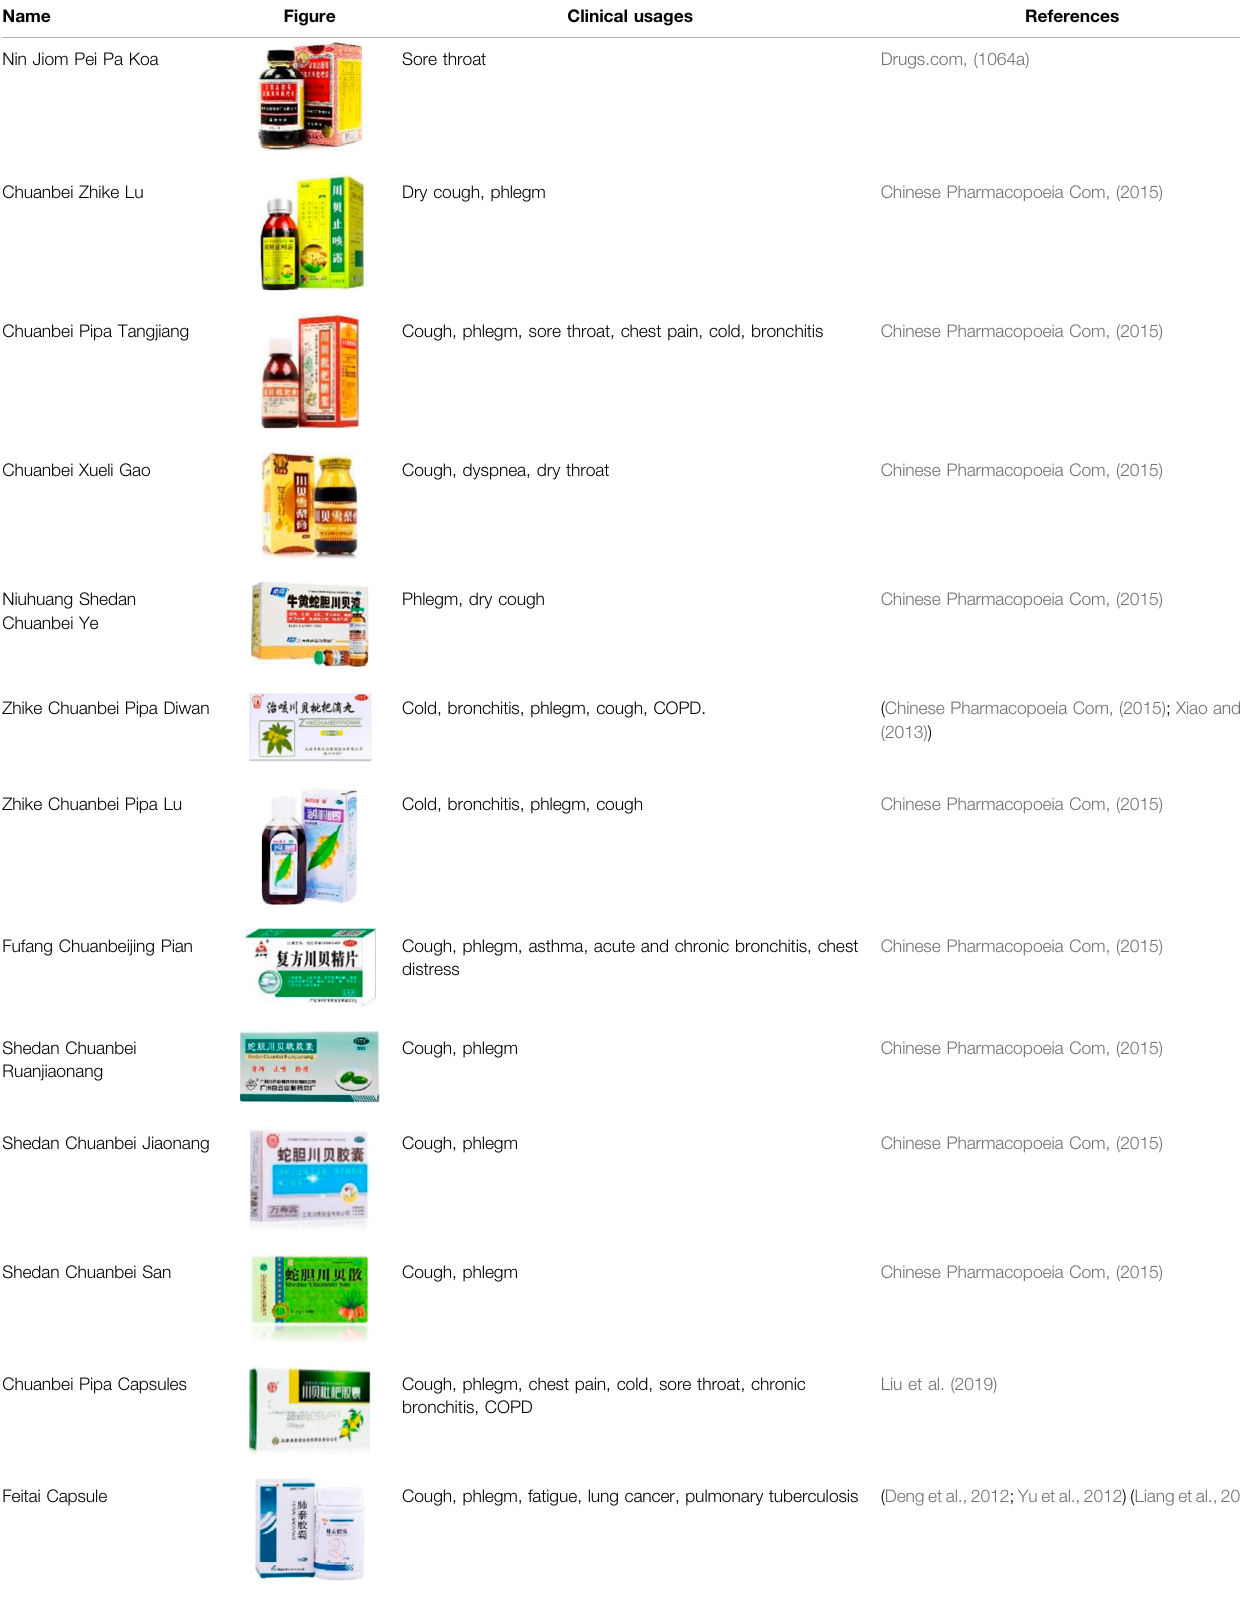
TABLE 1 | The main products related to BFC widely used to treat pulmonary diseases clinically